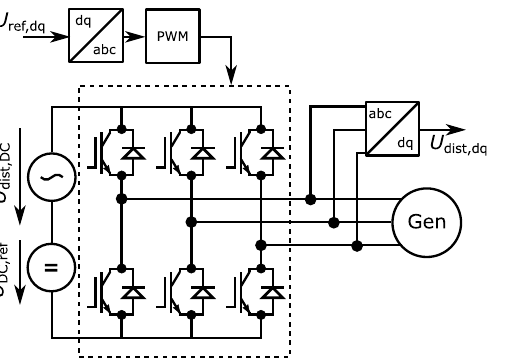
Figure 9. Implementation in Matlab/Simulink using PLECS for evaluation of U dq transfer function.